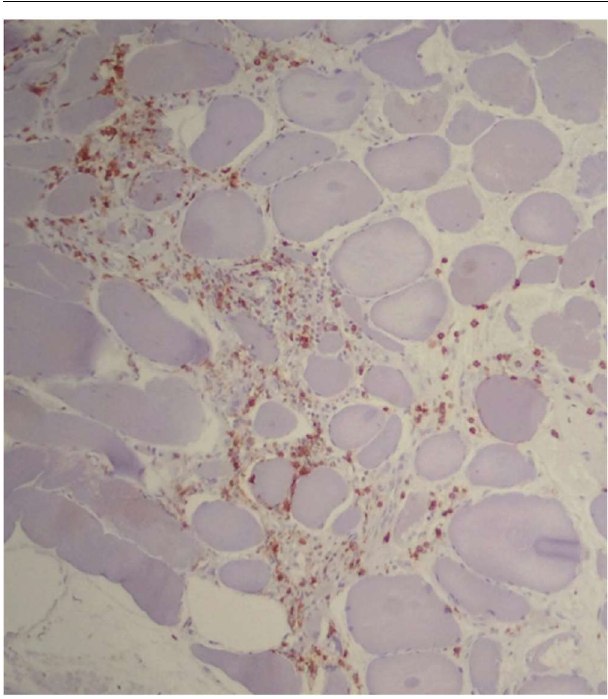
Legend; An H&E section of a muscle tissue showing infiltration of lymphocytes as well as myopathic features including smaller, rounded myofibers with increased internal nuclei. Courtesy of Meggen Walsh, D.O., M.S.-P.A. 22 Figure 3. CD8+ T Cell Infiltrate in Muscle Tissue